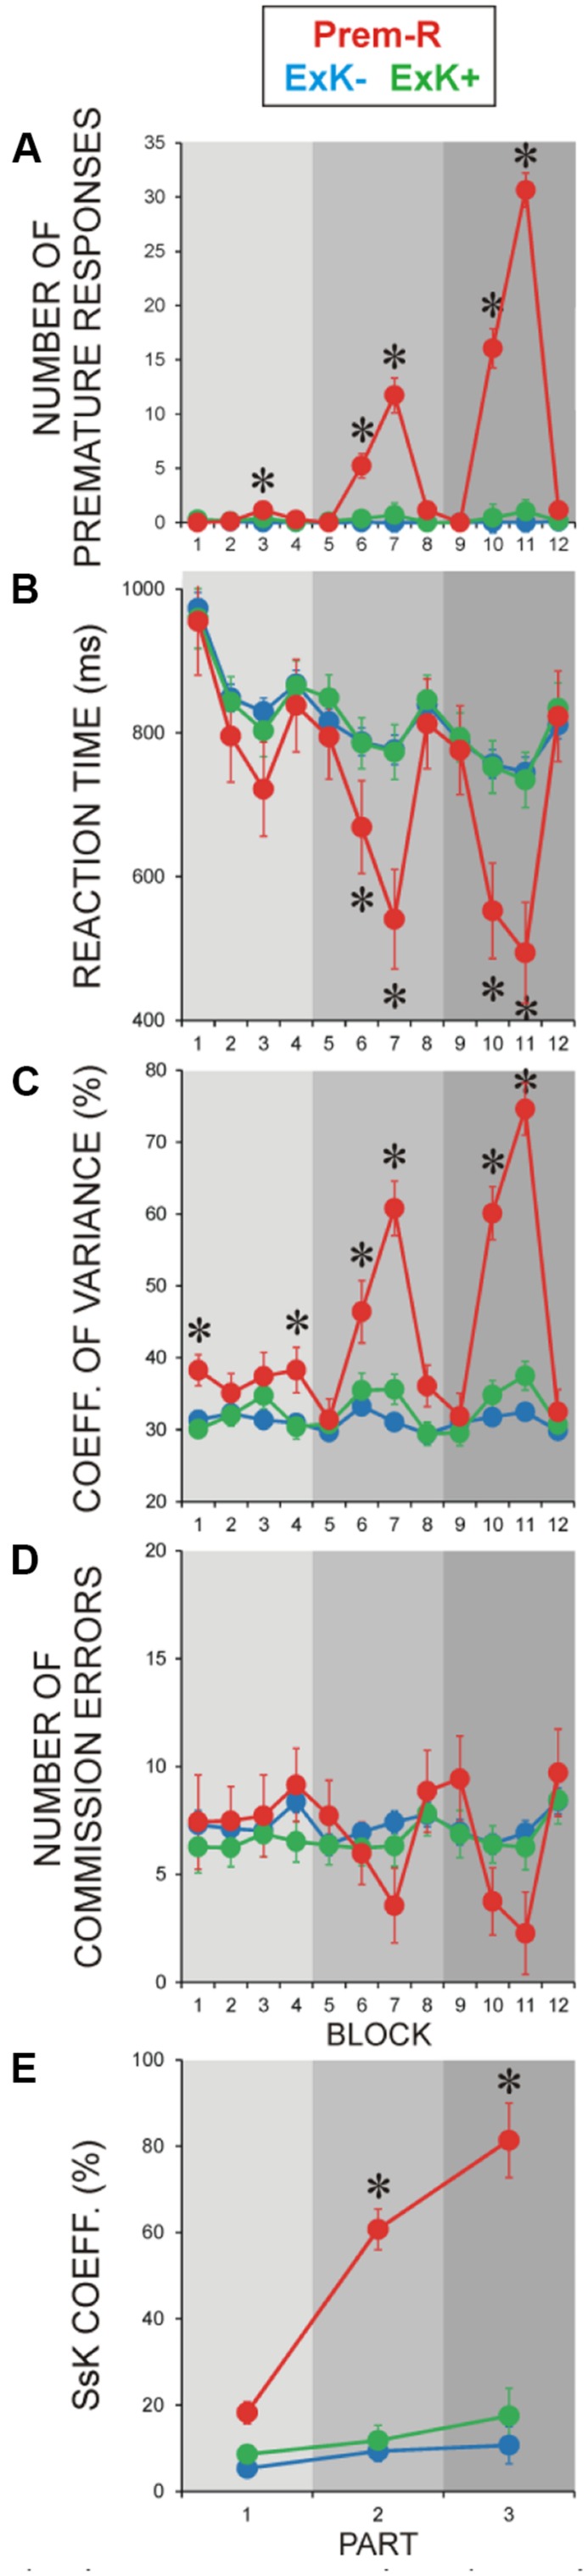
Performance parameters during pre-retention learning in participants with premature responses (Prem-R). Oﬄine explicit solvers (ExK+) and non-solvers (ExK-) are only illustrated to provide reference to Prem-R values and dynamics. (A) Number of premature responses during the learning session. (B) RTs, (C) Performance variance, (D) ER, (E) Sequence-specific knowledge (SsK) coefficient. Gray rectangles indicate three parts of experiment as shown in Figure 1A. Blocks 1–12 and parts 1–3 are designated as in Figures 1A and 2. Asterisks indicate blocks, in which the Prem-R group differed significantly (p = 0.05–0.001) from each of the four SsK × ExK sub-groups. Between-group differences were tested by MANOVA.